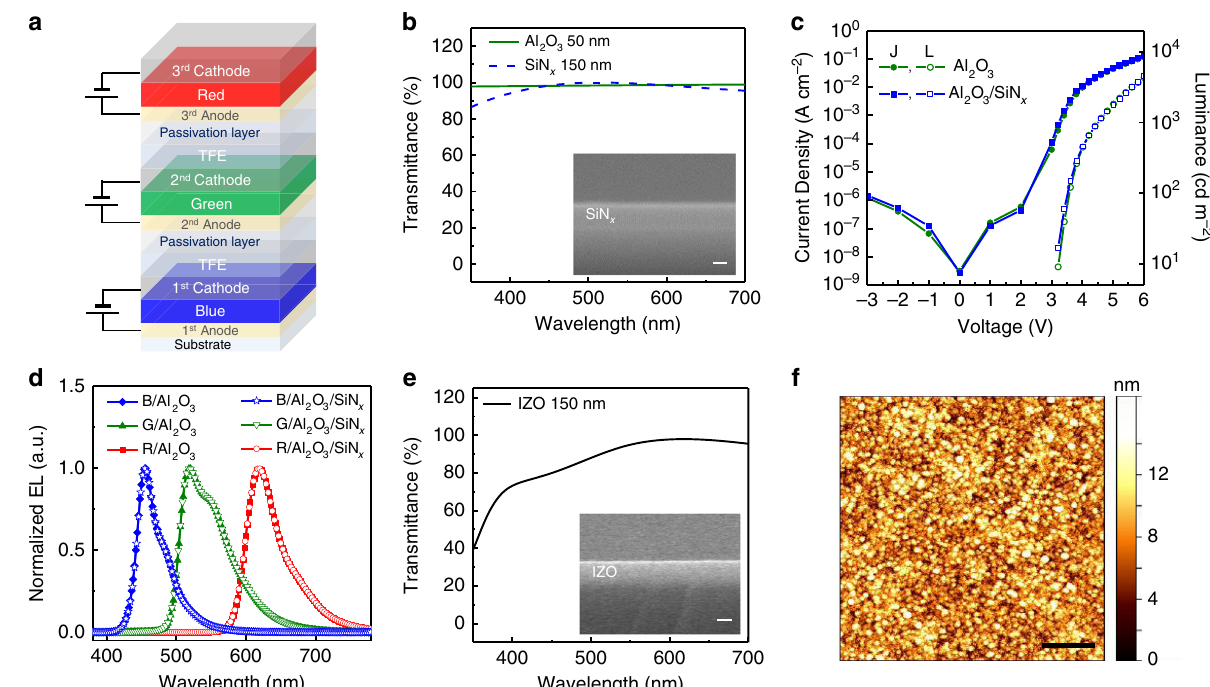
Fig. 1 Characterization of intermediate layers for vertically stacked full-color organic light emitting diodes (OLEDs). a Schematic of full-color OLED with vertically stacked red ( R ), green ( G ), and blue ( B ). b Transmittance spectra for the Al 2 O 3 (green solid line), and SiN x (blue dashed line) layers, and scanning electron microscope (SEM) image (inset) of the SiN x layer. Scale bar, 100 nm. c Current density ( J) – voltage ( V ) – Luminance ( L ) characteristics, d Electroluminescence spectra of OLED with Al 2 O 3 thin fi lm encapsulation, and Al 2 O 3 /SiN x passivation layer. OLED with Al 2 O 3 (blue line with closed diamond for B , green line with closed triangle for G , and red line with closed square for R ), and OLED with Al 2 O 3 /SiN x (blue line with open star for B , green line with open down triangle for G , and red line with open circle for R ). e Transmittance spectrum and SEM image (inset) of indium zinc oxide (IZO) intermediate electrode. Scale bar, 100 nm. f Atomic force microscope image of OLED/Al 2 O 3 /SiN x /IZO. Scale bar, 1 μ